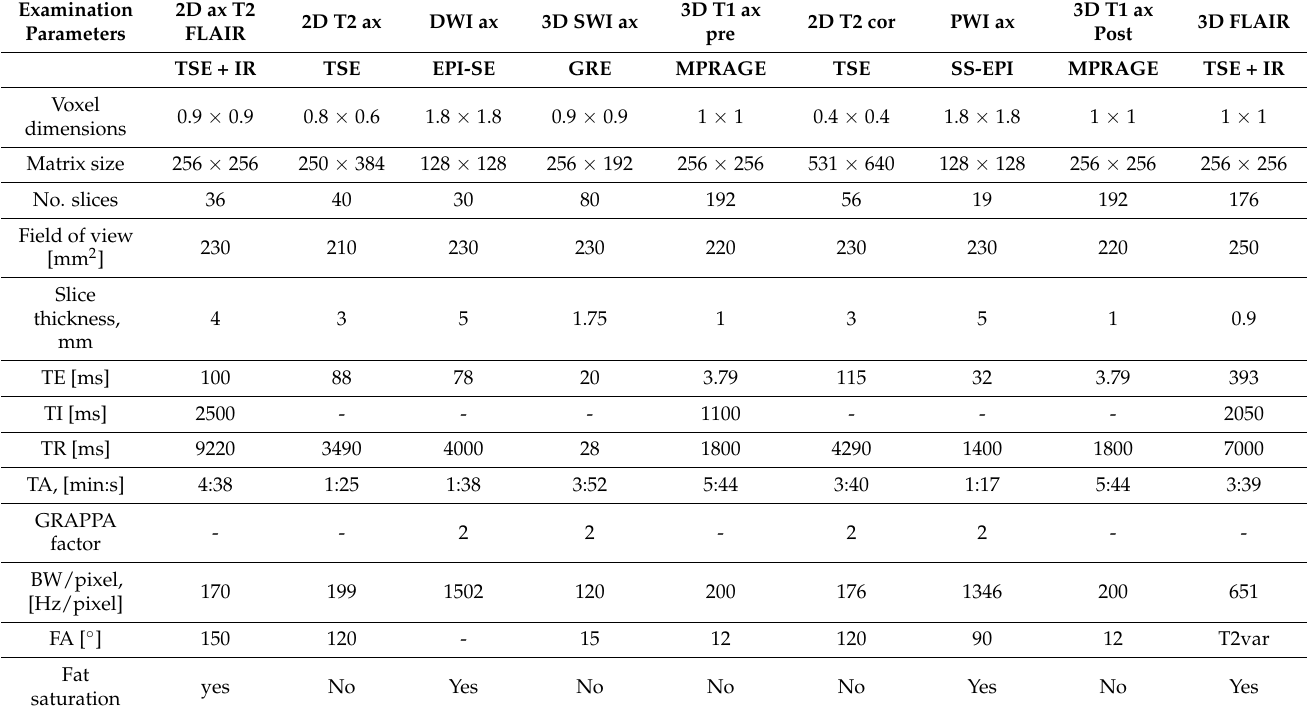
Table 2. Conventional MR brain tumor protocol used for 3